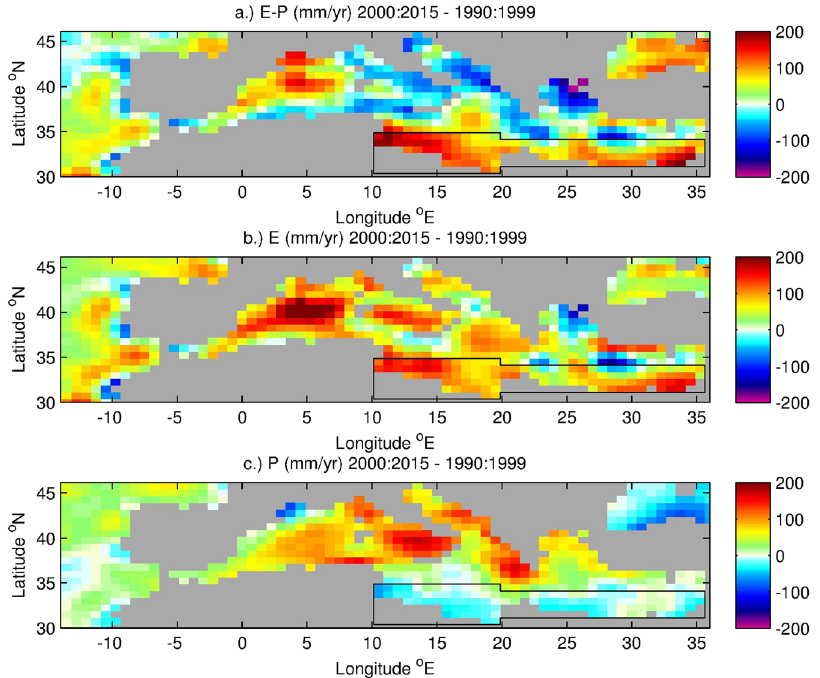
Figure 3. Difference of ERA-Interim annual mean surface freshwater flux and its components averaged over 2000–2015 from 1990–1999. ( a ) Evaporation – Precipitation (mm yr − 1 ), ( b ) Evaporation (mm yr − 1 ) and ( c ) Precipitation (mm yr − 1 ). The black outline shows the south-eastern Mediterranean box used to determine the time series shown in Fig. 4.